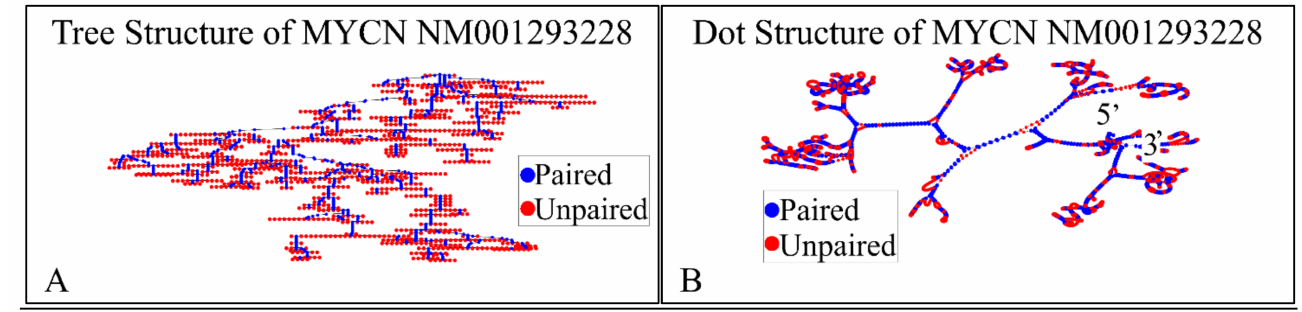
Figure 8. The predicted secondary structure of the MYCN , NM001293228 transcript. In particular, the tree structure ( A ) and the dot structure ( B ) of the transcript are presented (predictions were performed with the Matlab ® (The Mathworks, Inc., Natick, MA, USA), using the RNAfold